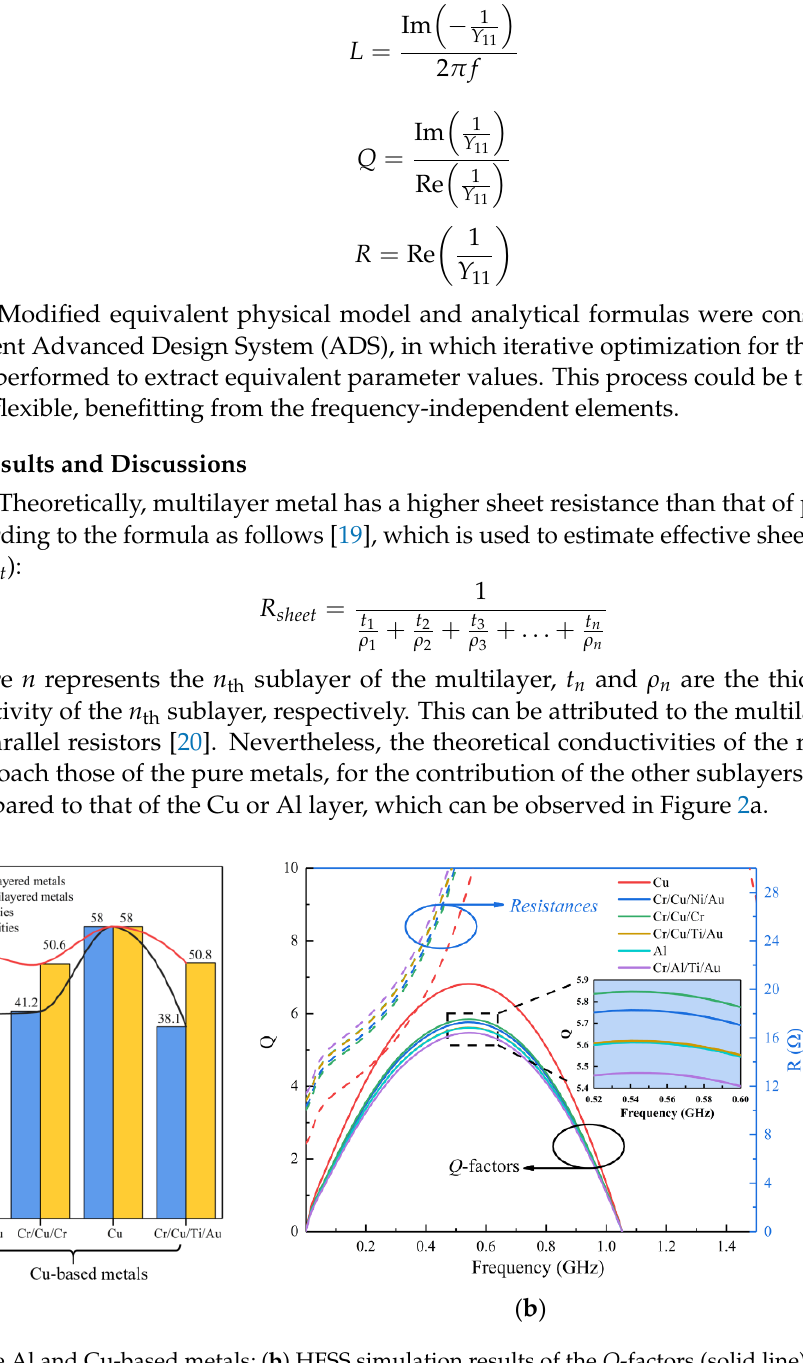
Figure 2. ( a ) Conductivities of the Al and Cu-based metals; ( b ) HFSS simulation results of the Q -factors (solid line) and R (dashed line) of the inductors as a function of frequency.